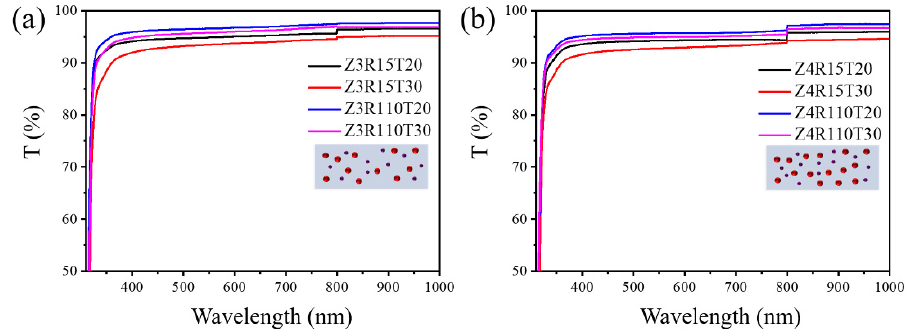
Figure 8. Transmission spectrum of the polymeric coatings that were directly mixed with two